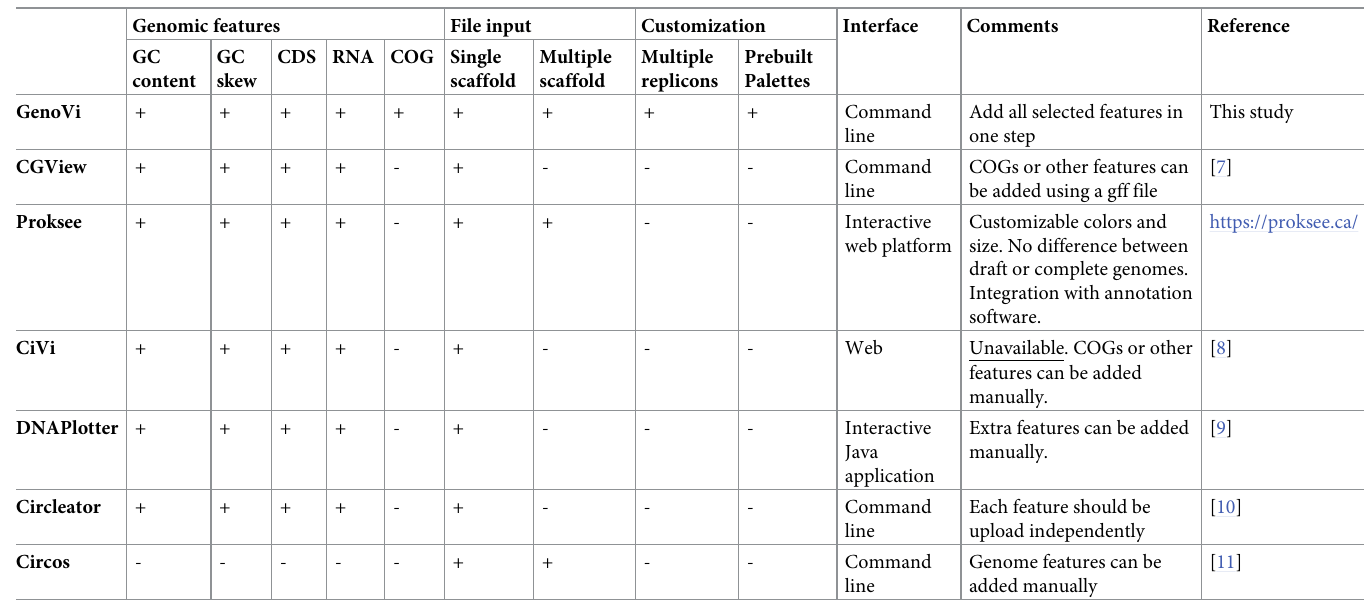
Table 1. Comparison of circular genome visualization